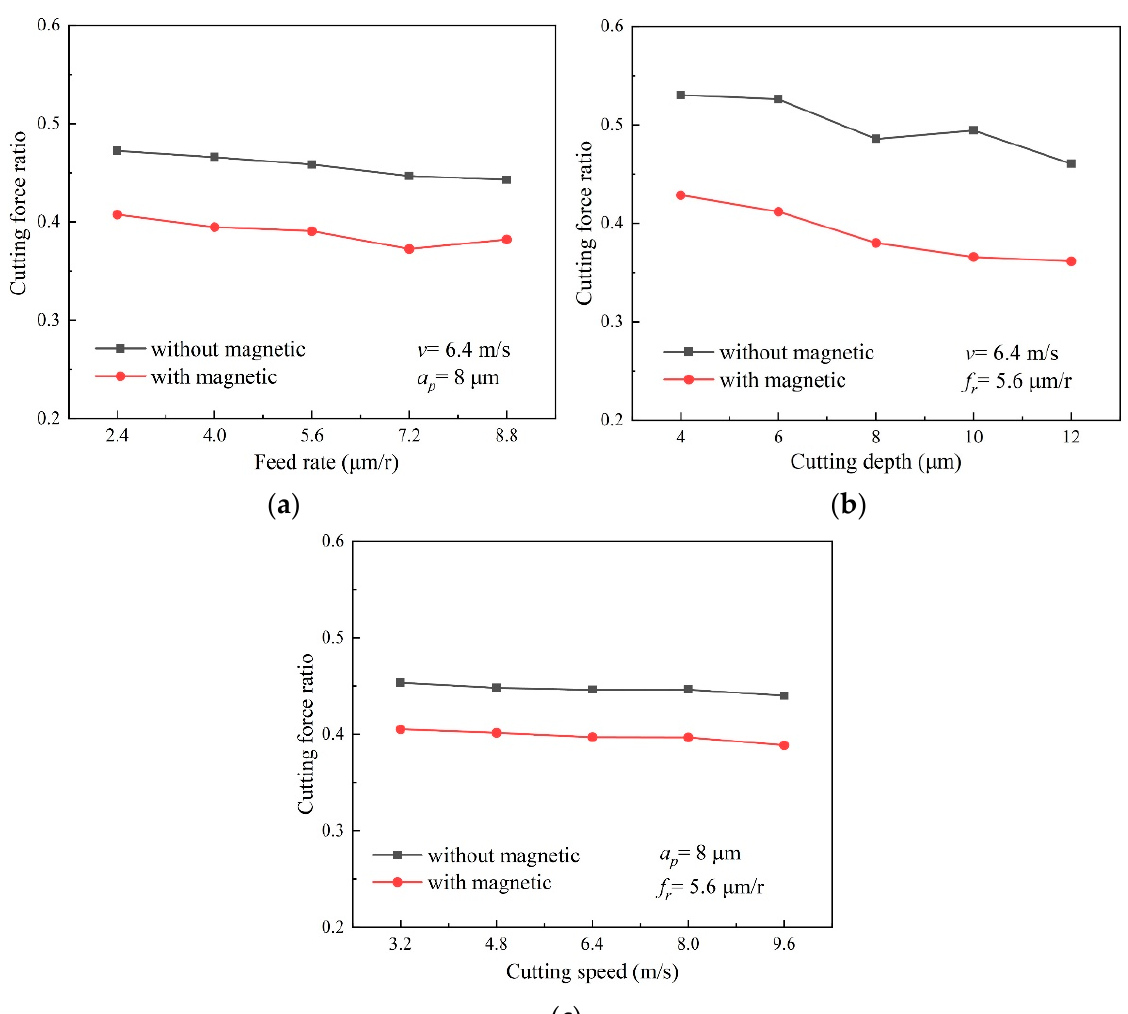
Figure 9. Effect of magnetic-field action on cutting-force ratio, ( a ) cutting-force ratio varying with feed rate, ( b ) cutting-force ratio varying with depth of cut, ( c ) cutting-force ratio varying with cutting speed.